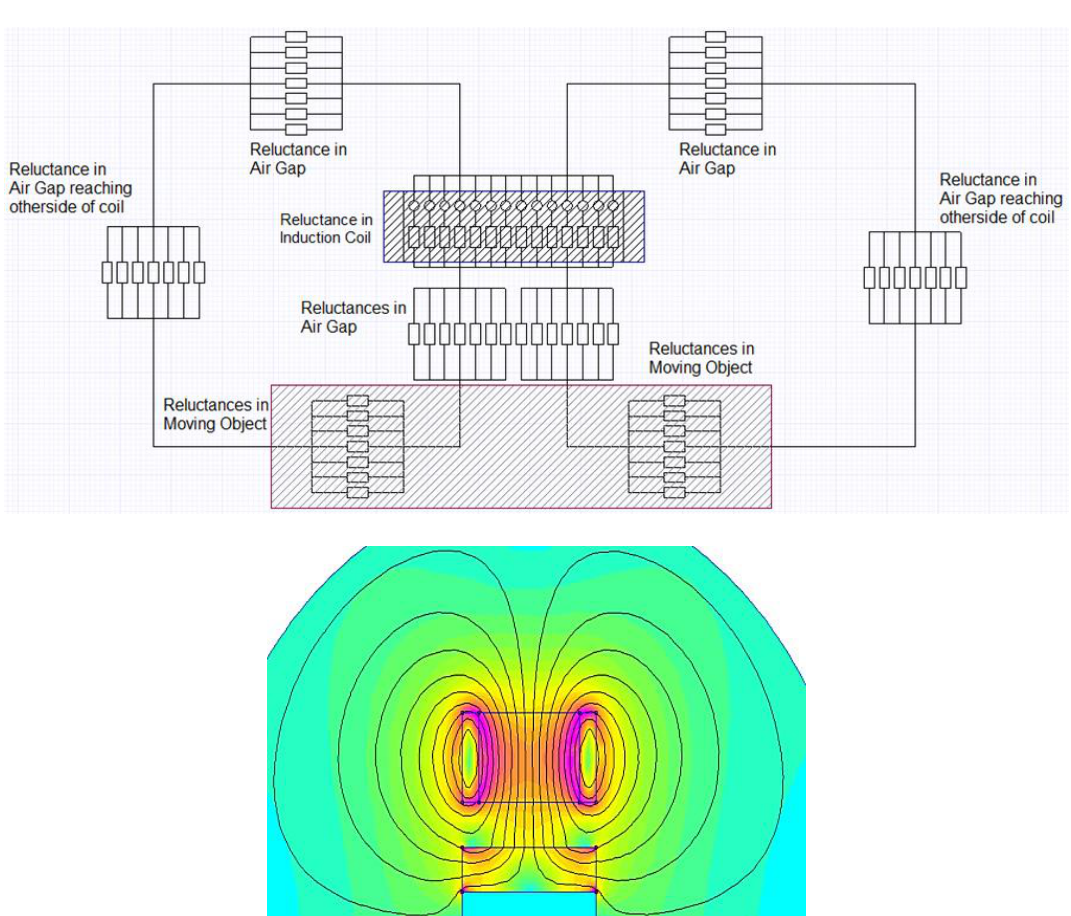
Figure 3. Magnetic circuit of MFEML for single coil (right side view) and different flux lines from